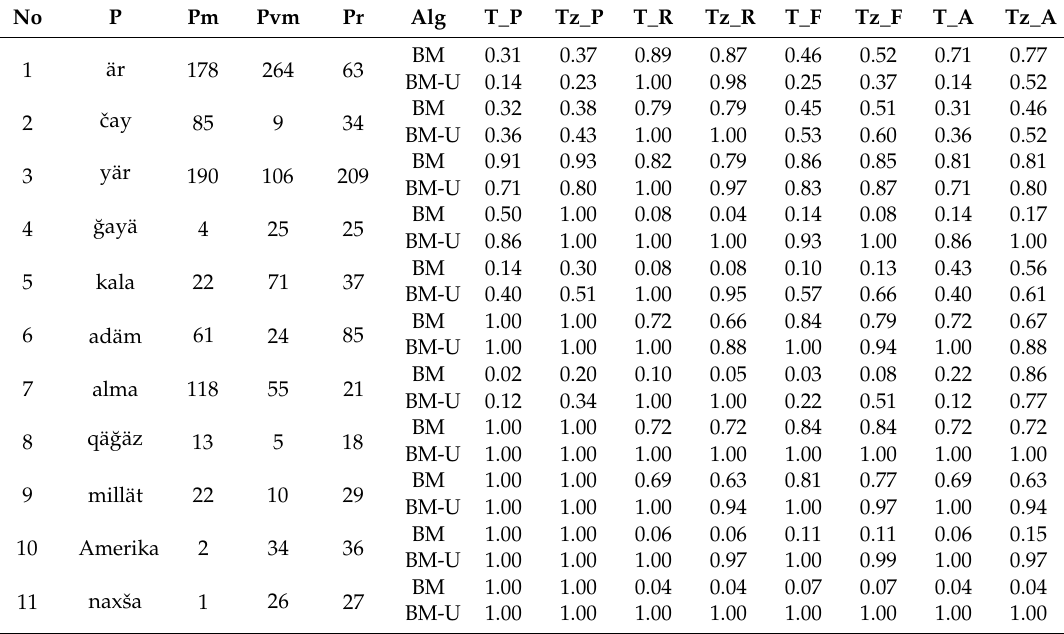
Table 6. Matching results of words with vowel weakening.